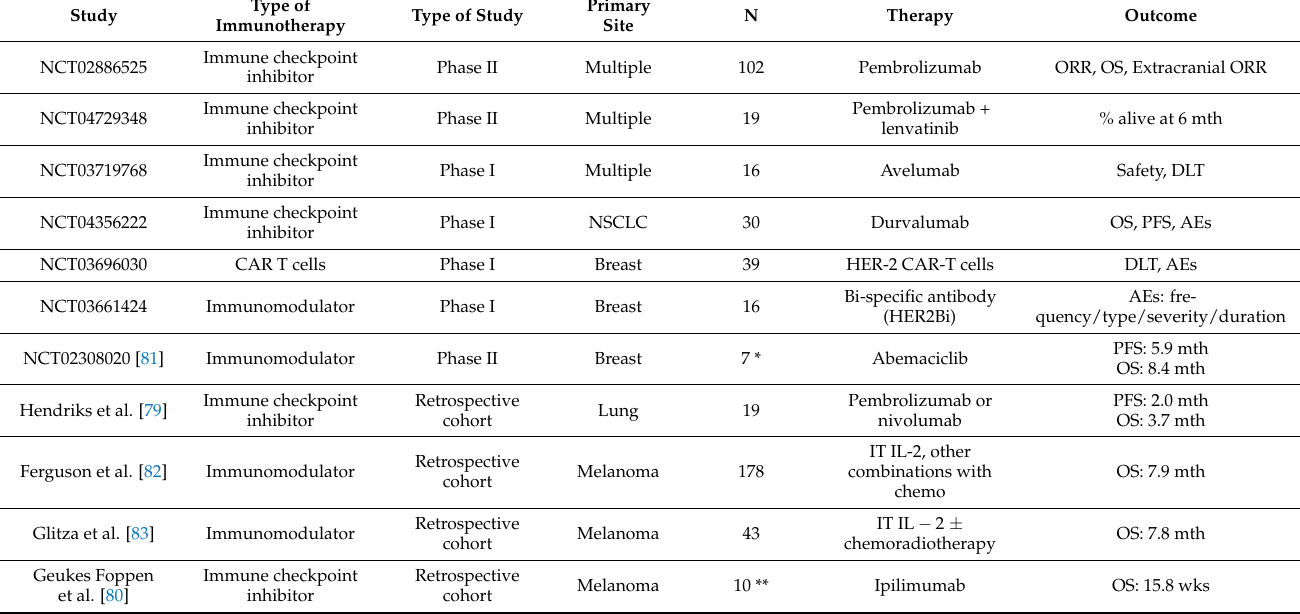
Table 5. Overview of clinical trials evaluating immunotherapy in neoplastic meningitis. Original table, updated till October 2022. Abbreviations: OS: Overall survival, PFS: Progression-free survival, DLT: Dose Limiting Toxicity, ORR: Objective Response Rate, A/E: Adverse Effects, IT: Intrathecal, CAR-T: